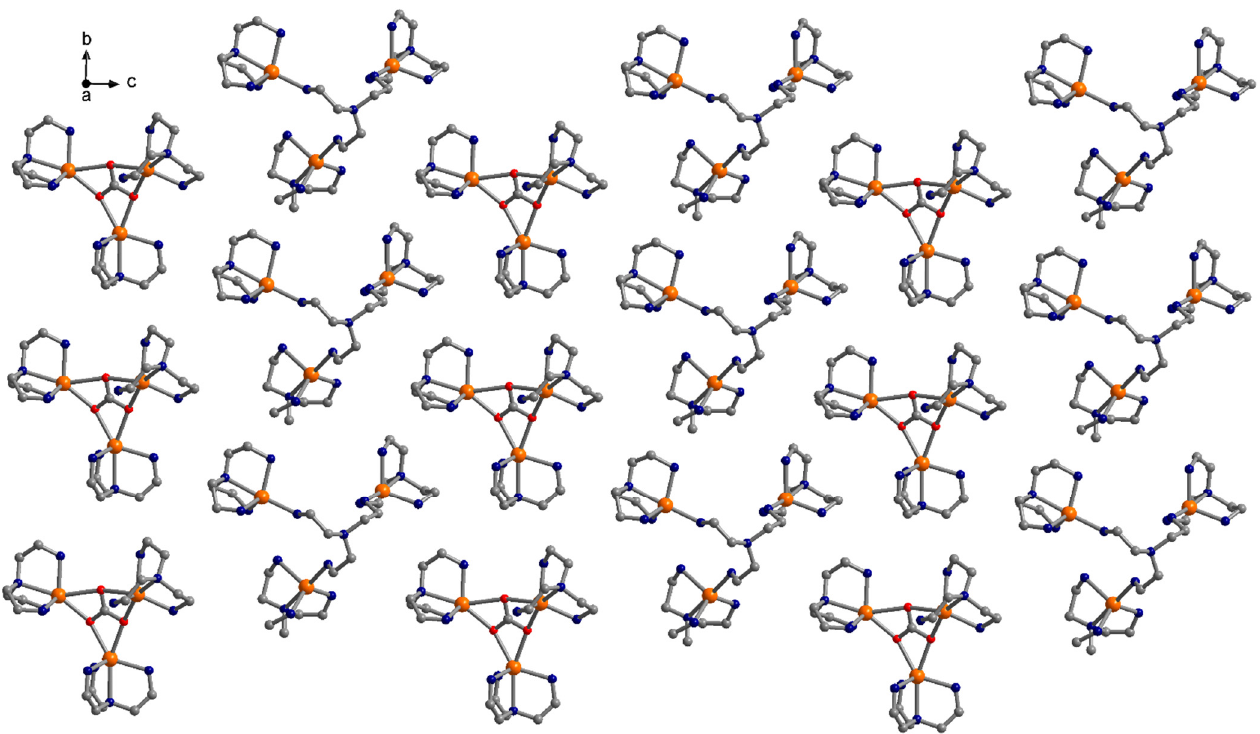
Figure 4. View along the crystallographic a axis of a packing diagram in crystal 2 showing the alternating distribution of the types of cations, [{Cd(tren)} 3 (tren)] 6+ and [{Cd(tren)} 3 ( µ 3 -CO 3 )] 4+ , in the crystallographic bc plane. The hydrogen atoms and perchlorate anions were omitted for clarity.